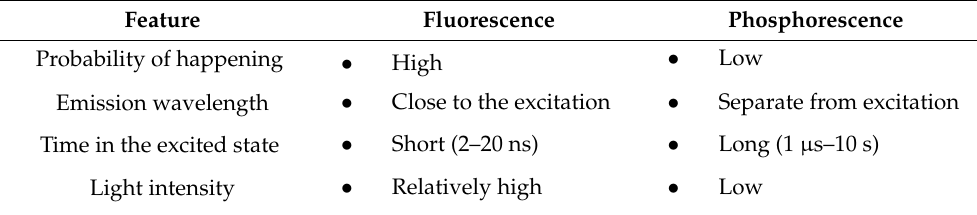
Table 5. Comparison of fluorescence and phosphorescence